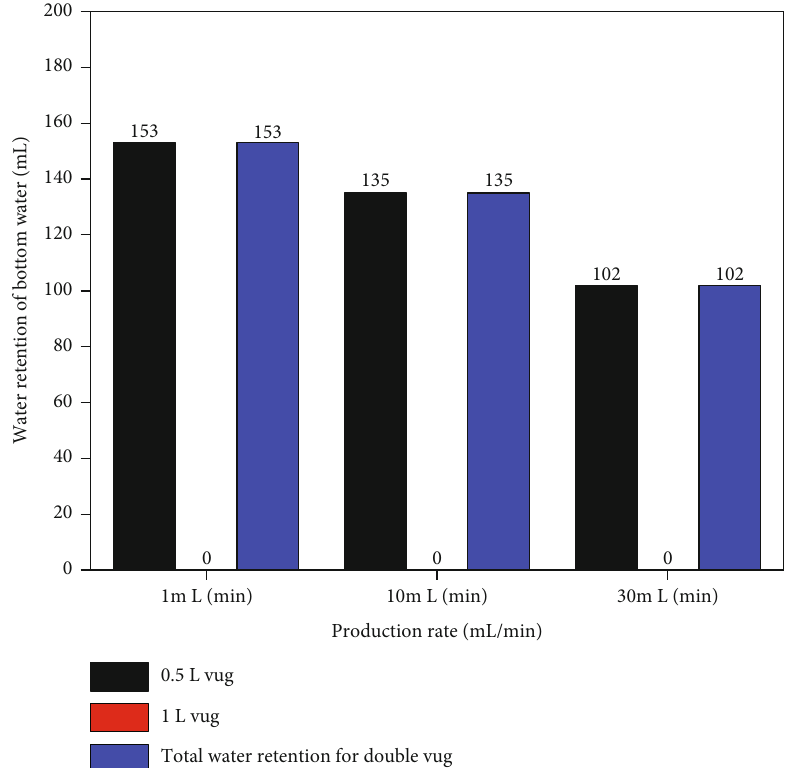
Figure 12: Column chart of bottom water invasion and retention in high-pressure physical property experiments under connection type II (di ff erent production rates).